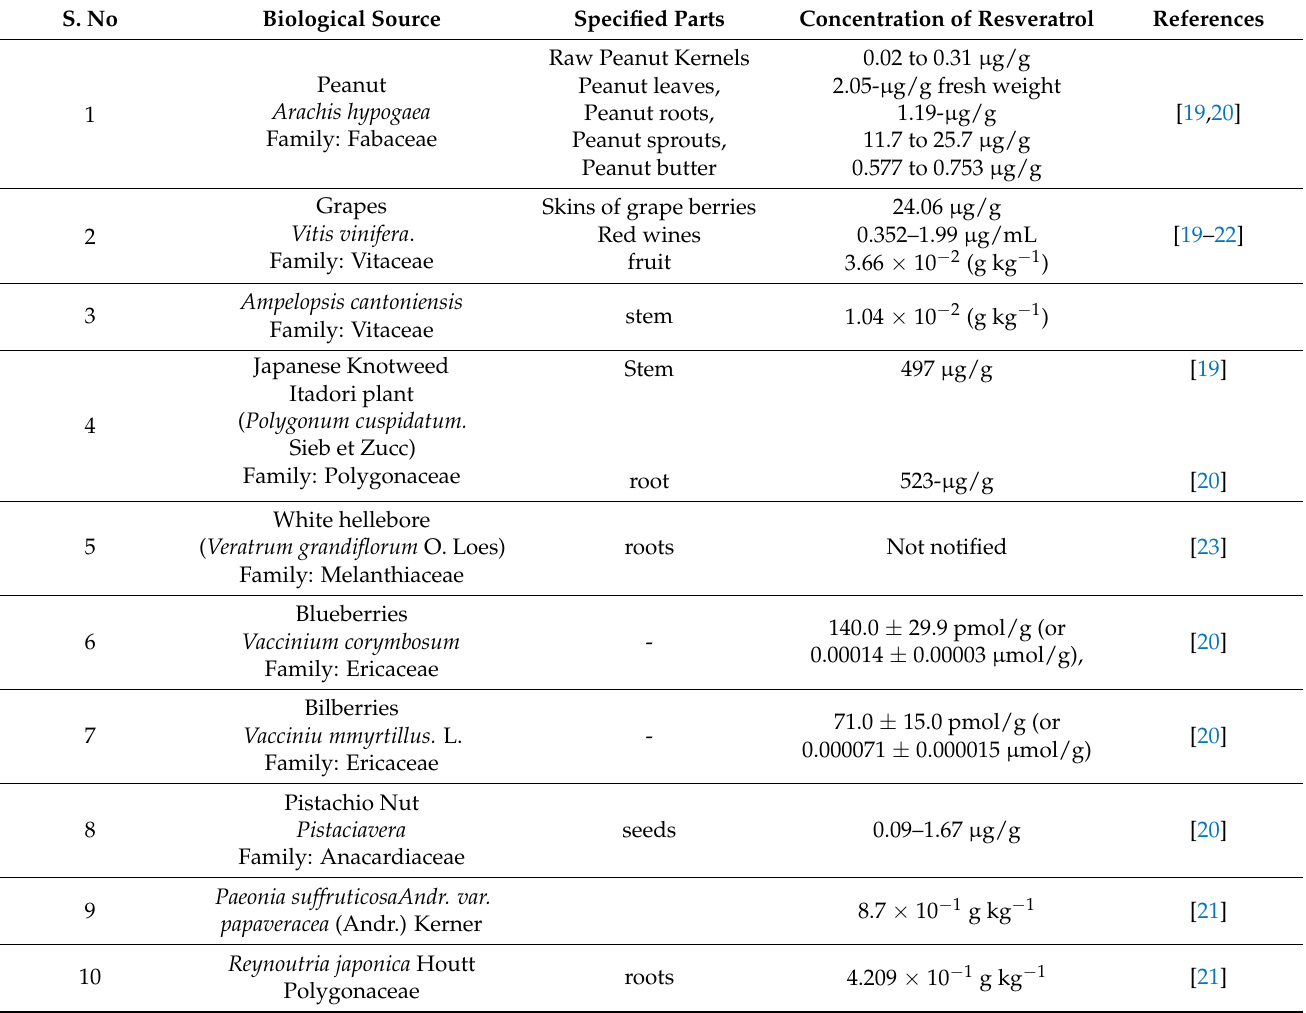
Table 1. List of biological sources of resveratrol and their concentration.